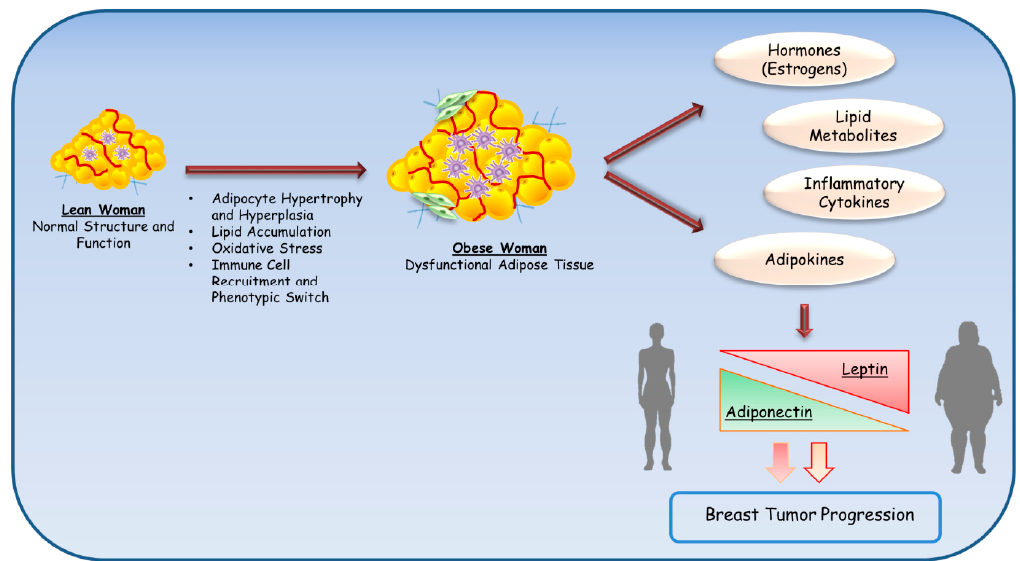
Figure 2. Adipose tissue alterations during weight gain. Obese adipose tissue